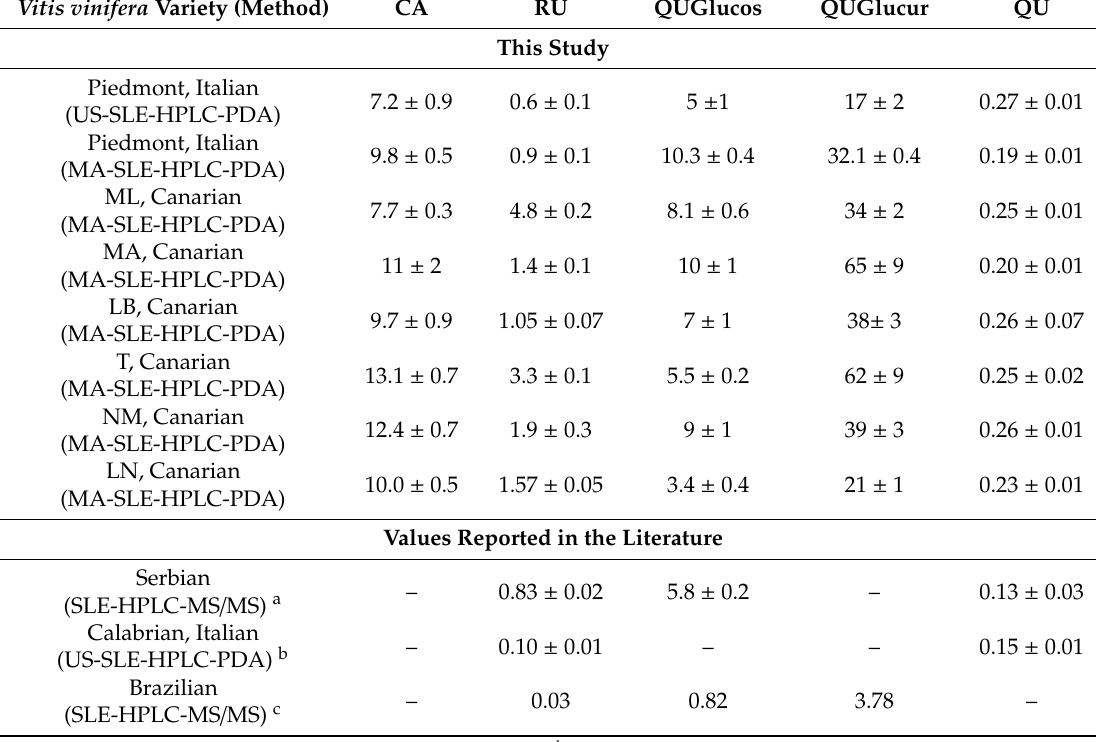
Table 1. Phenolic content in the di ff erent Vitis vinifera varieties analyzed in this study, expressed as mg · g − 1 ± SD (for three replicates) and using the MA-SLE method and the US-SLE method for comparison purposes, together with the amounts reported in the literature for other varieties and using di ff erent